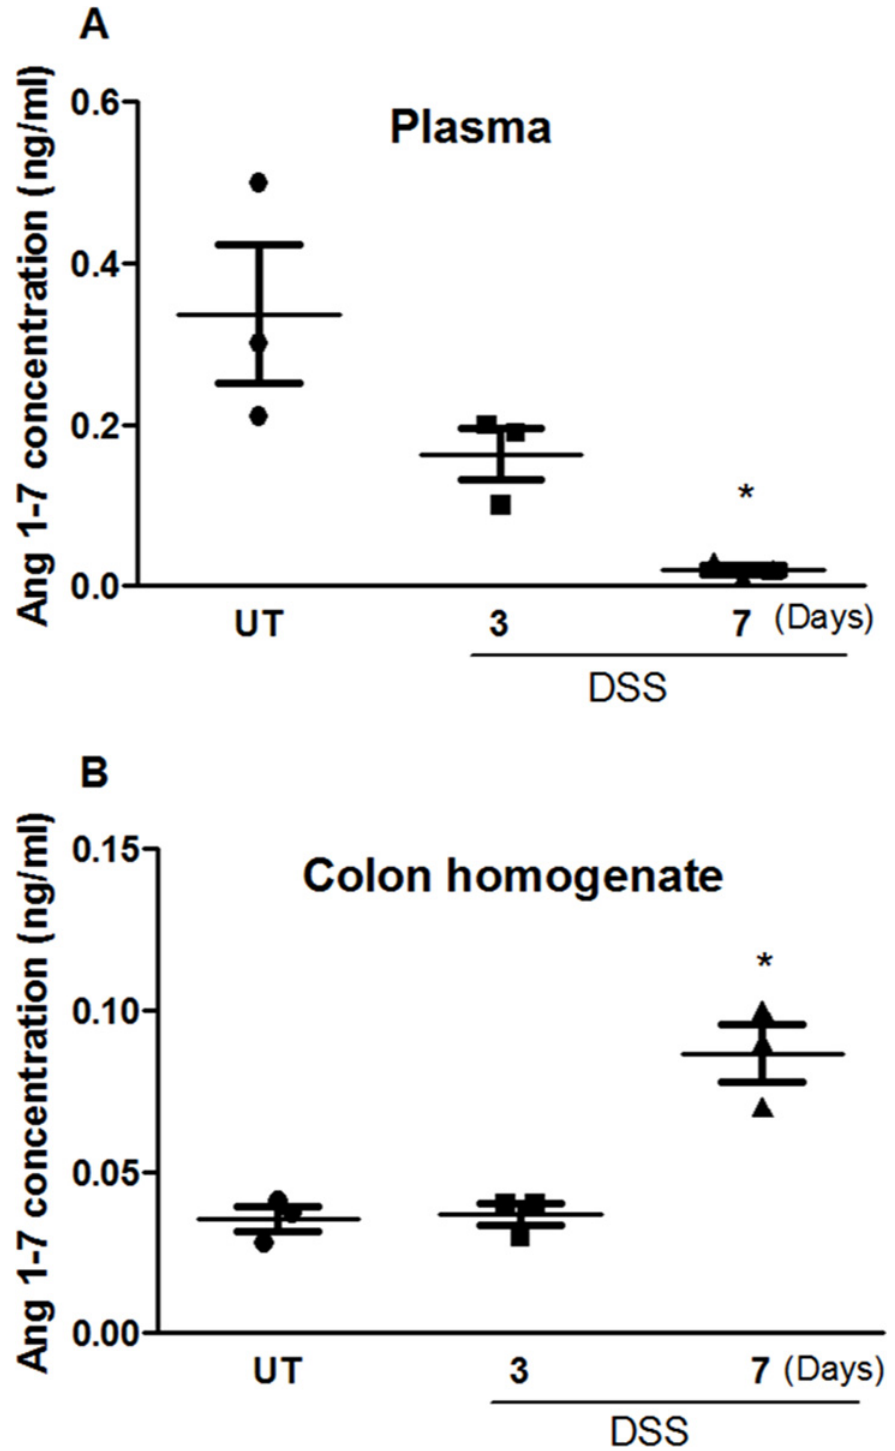
Fig 1. Ang 1 – 7 protein levels post-colitis induction. Ang 1 – 7 levels were measured in plasma (A) and colon homogenates (B) at 3 and 7 days after treatment with 3.5% DSS (open bars), and compared to untreated (UT) mice (solid bars). Histobars represent the mean values ± SEM for 3 mice per group. Asterisks indicate significant difference from UT group with p < 0.05.